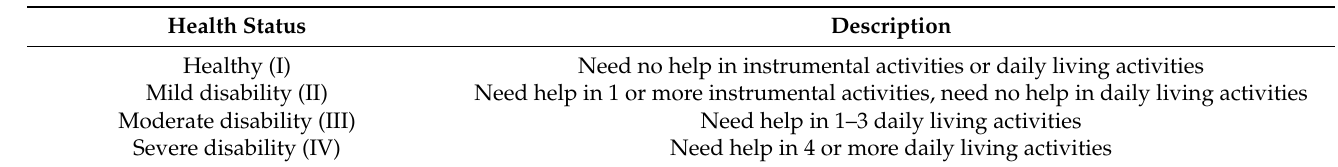
Table 1. Definition of the health status of the